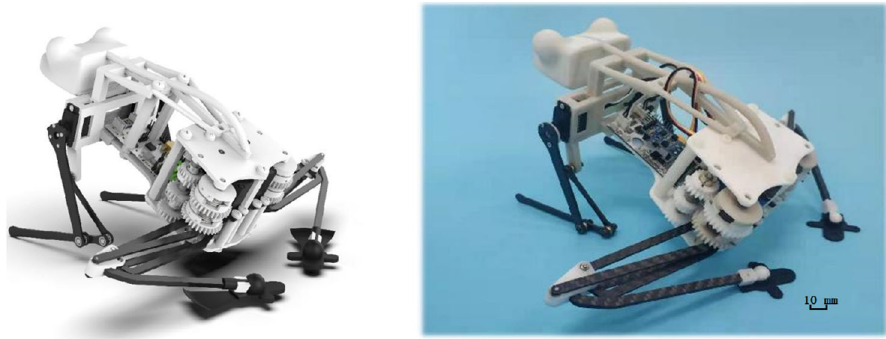
Figure 12. The overall structure model of the robot and the actual prototype.